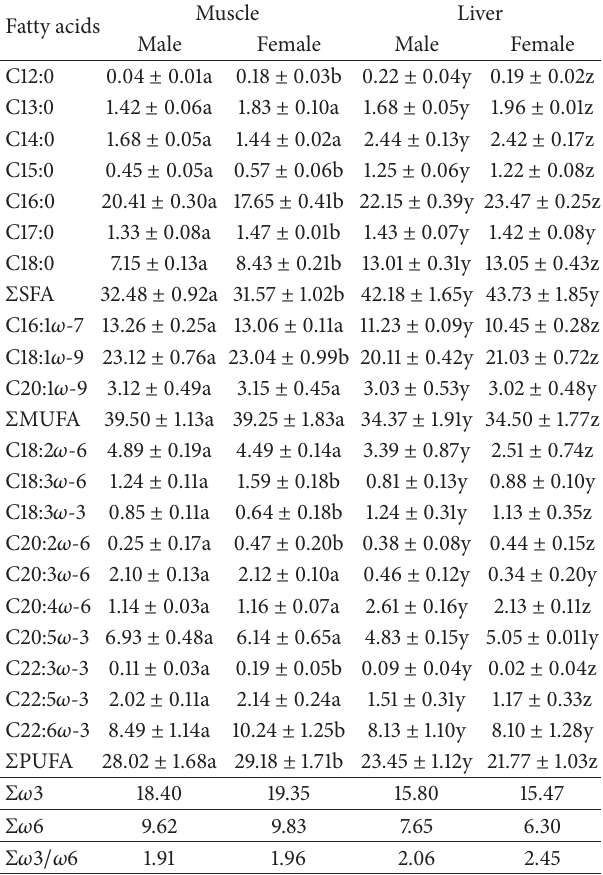
Table 4: Comparison of males and females in terms of muscle and liver fatty acid composition of triacylglycerol in L. lepidus